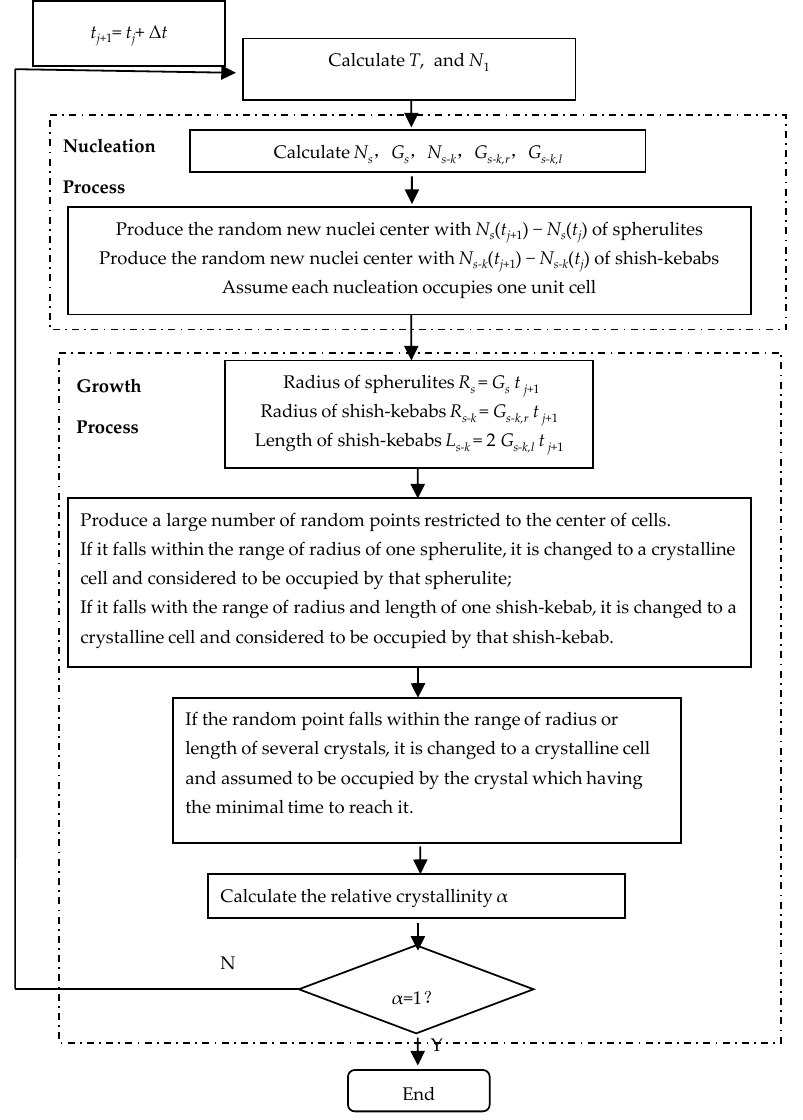
Figure 1. Flow chart for the Monte Carlo method in the simulation.